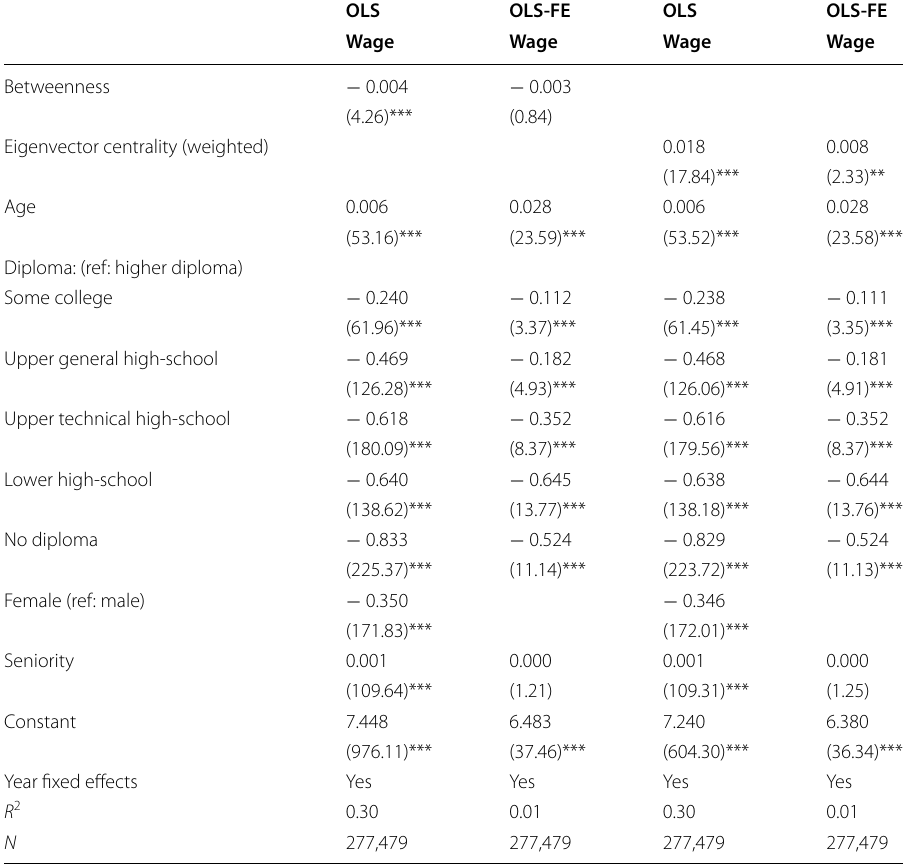
Table 7 Alternative centrality measures and wage